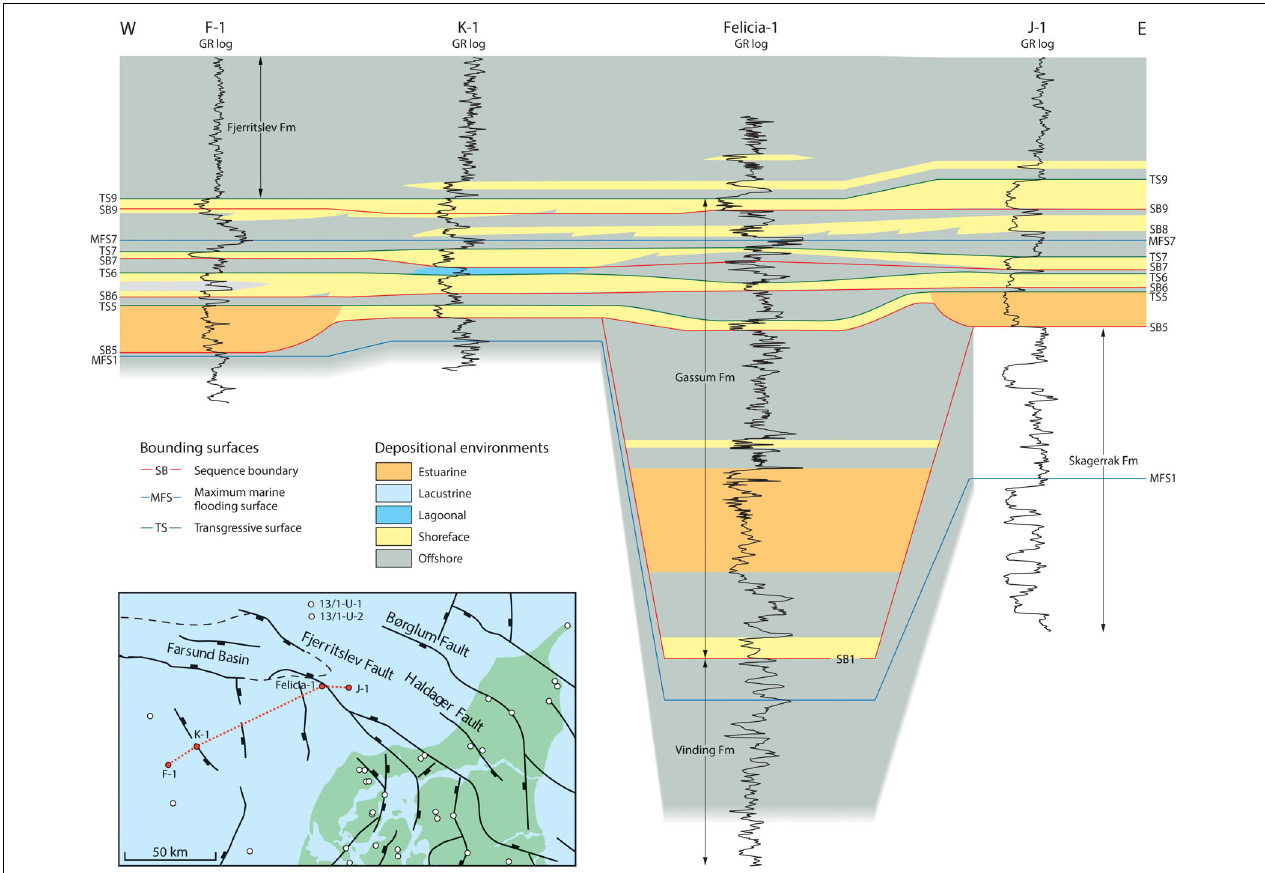
FIGURE 6 | Interpreted sequence stratigraphy and depositional environments of the Gassum Formation in the Skagerrak tied to the framework defined in wells onshore Denmark by Nielsen (2003). Oblique depositional dip section. The MWD-GR (measured while drilling – gamma ray) log is used for Felicia-1 since this is the most reliable because caving occurred during